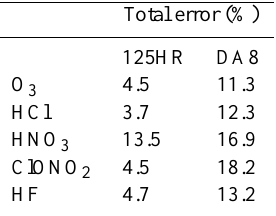
Table 1. Springtime mean (for the period 24 February to 6 April) total errors for ozone, HCl, HNO 3 , ClONO 2 , and HF total columns retrieved from the FTIR spectra. The total error was calculated as described in Sects. 2.1 and 2.2,